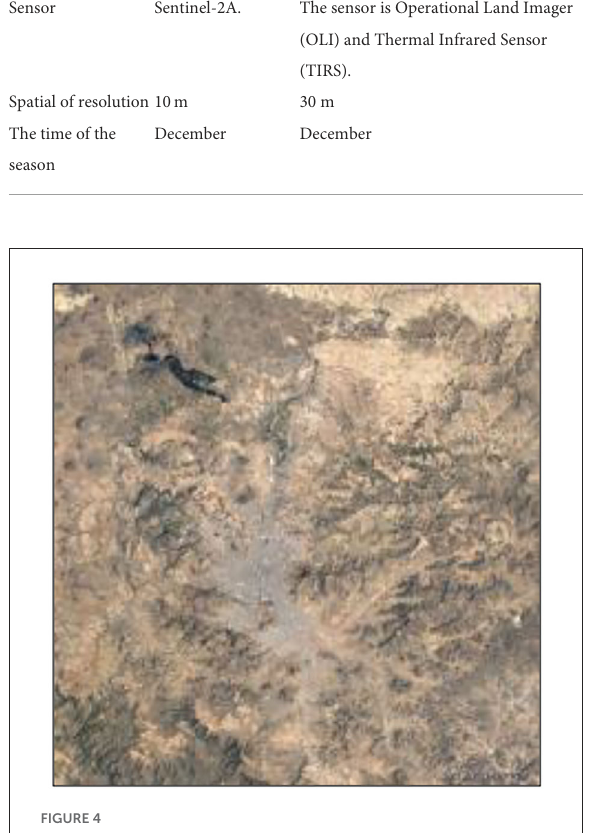
FIGURE4 Sana’a area on the Google